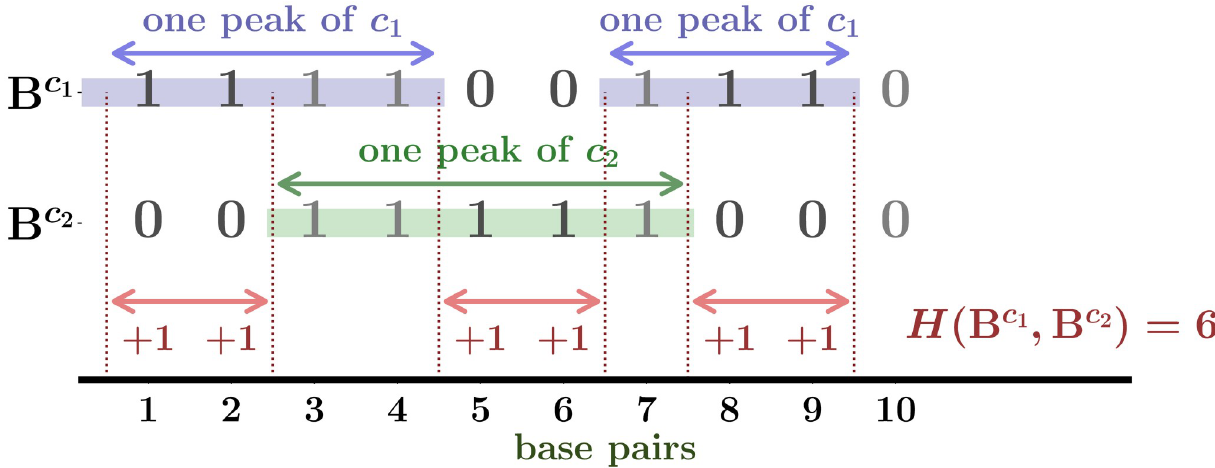
Fig 3. How to calculate Hamming distance. Schema of the Hamming distance calculation from the peak locations with two samples c locus is converted to 1 or 0 based on the peak overlapping status.